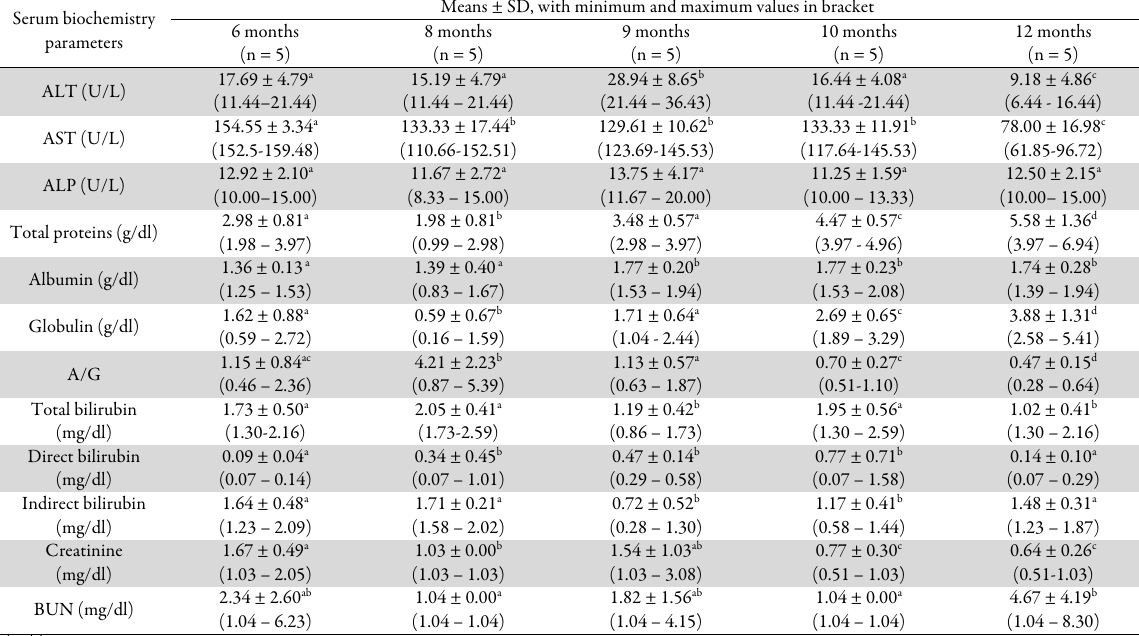
Table 2. Age differences in the serum biochemistry profile of broodstock African catfish ( Clarias gariepinus ) Means ± SD, with minimum and maximum values in bracket Serum biochemistry 6 months parameters